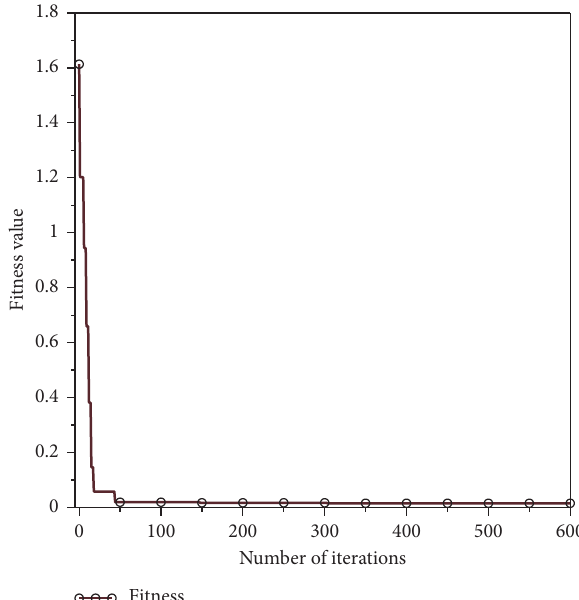
Figure 6: The fitness value with respect to iteration loops of the whale optimization algorithm for the first